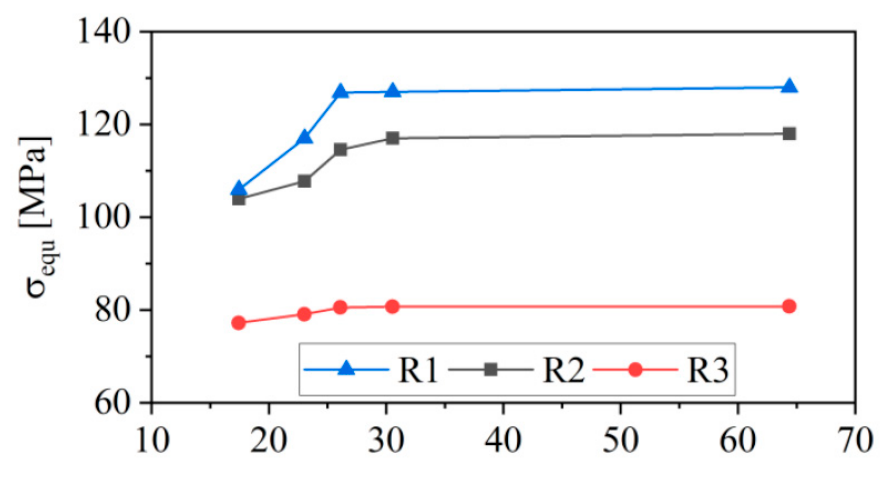
Figure 2. Mesh independency analysis.